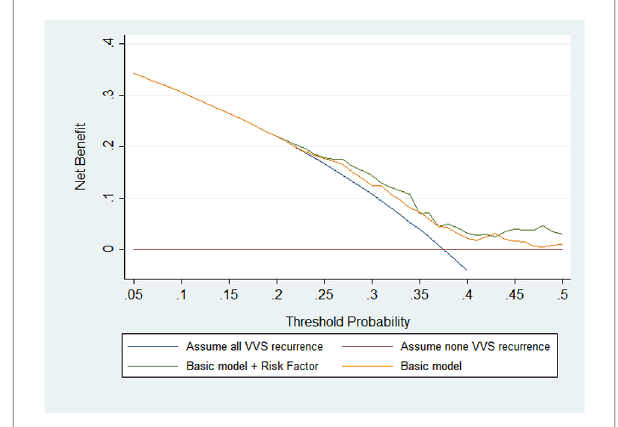
FIGURE 1 Prognostic decision curves for the basic model and the addition of MAP-supine and urine speci fi c gravity in vasovagal syncope patients. The basic model included age, sex, body mass index, medical history, and family